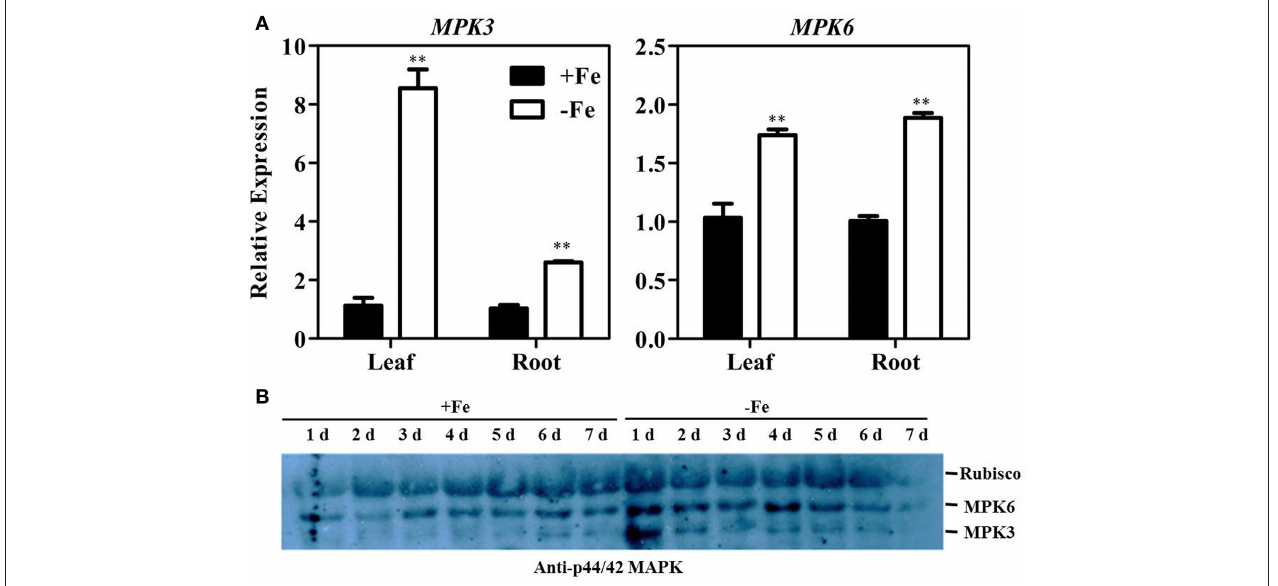
FIGURE 5 | Fe deficiency activates MPK3 and MPK6. (A) Transcription levels of MPK3 and MPK6 in the leaf and root of WT seedlings under Fe-sufficient (50 µ M EDTA-Fe) and -deficient (0 µ M EDTA-Fe) conditions. All values are expressed relative to the expression level under Fe-sufficient conditions (control—set to 1.0) as appropriate. Data are shown as the mean ± SEM ( n = 3 ). (B) Immunoprecipitation kinase assay of MPK3 and MPK6 activity using Anti-p44/42 MAPK antibody. Ten-day-old seedlings were transferred to Fe-sufficient or -deficient nutrient solutions. Column marked with “ ** ” indicate a highly significantly difference ( P < 0.01